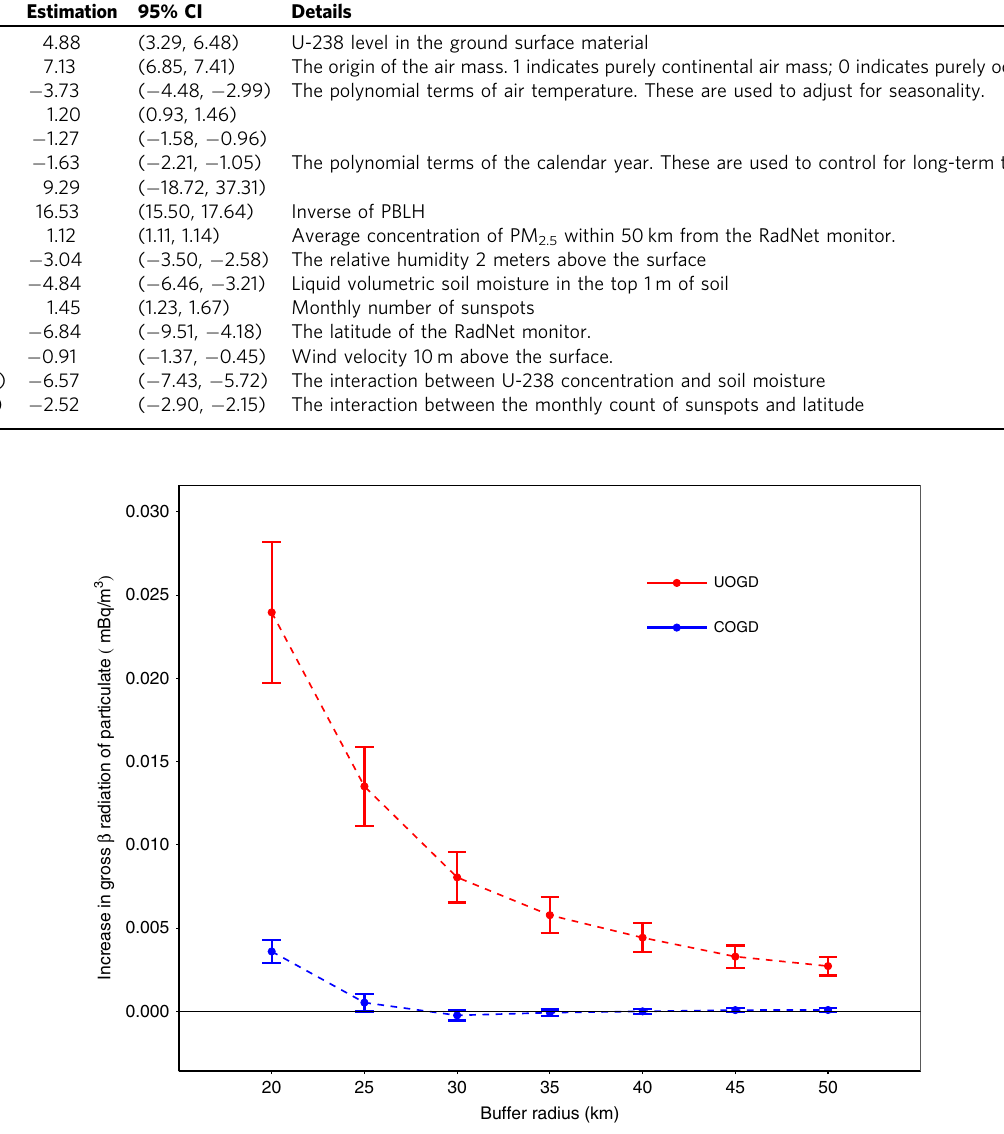
Fig. 2 The association between upwind O&G production activities and downwind level of PR. The increase in PR associated with an additional 100 UOGD wells (blue bars) and COGD wells (red bars) at multiple buffer distance. Effect estimations are visualized as the points and the 95% Cis are visualized as the bars. The source data of this fi gure is provided in Supplementary Table